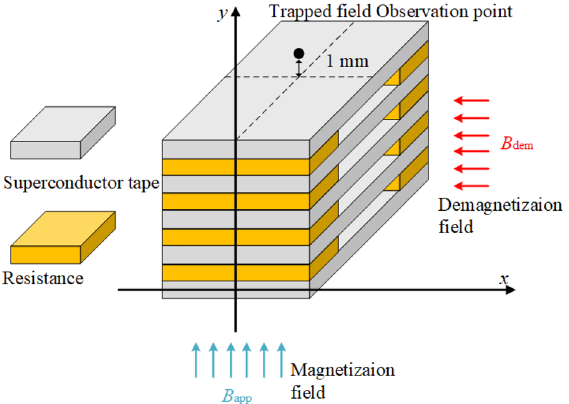
Figure 1. A sketch of the superconducting stack with resistances at terminals. The gray parts are the superconducting layers and the yellow parts are the resistances between tapes. A field along y axis is applied ( B app ) on the HTS tapes to magnetization. Then, an alternating triangular magnetic field along the x axis is applied ( B dem ) to demagnetize the stack. The trapped magnetic field B trapped (along y axis direction) is observed at 1 mm above the top tape surface